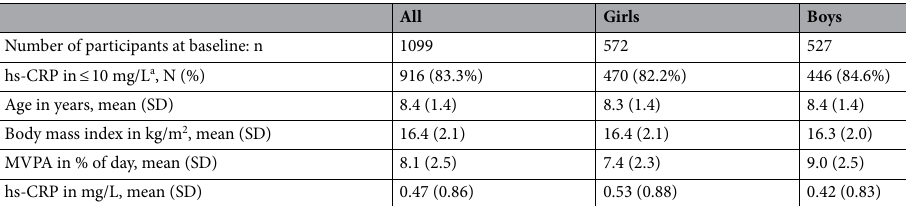
Table 1. Number, age, body mass index, and sex of participants at baseline, plus the number of participants meeting the hs-CRP inclusion criteria and participating in a study investigating the association between sub-clinical elevation of C-reactive protein and spinal pain trajectories in children and adolescents. hs-CRP (≤ 10 mg/L) a : those with hs-CRP (≤ 10 mg /L), which indicates acute inflammation. SD standard deviation, MVPA moderate-to-vigorous physical activity, hs-CRP high sensitivity C-reactive